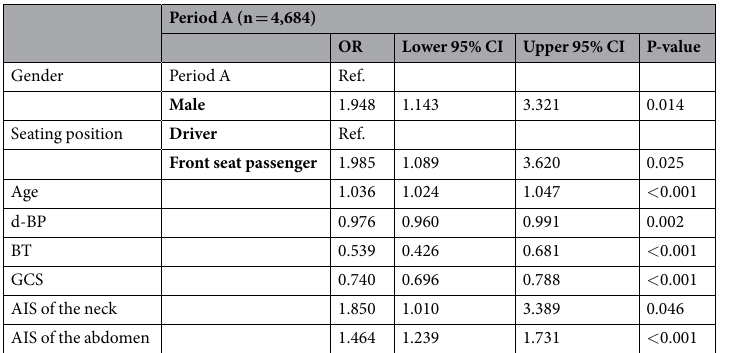
Table 7. Results of multivariate analyses to identify the factors associated with fatality in Period A (2004–2008). d-BP: diastolic blood pressure, BT: body temperature, GCS: Glasgow coma score, AIS: Abbreviated Injury Scale, OR: odds ratio, 95% CI: 95% confidence interval.